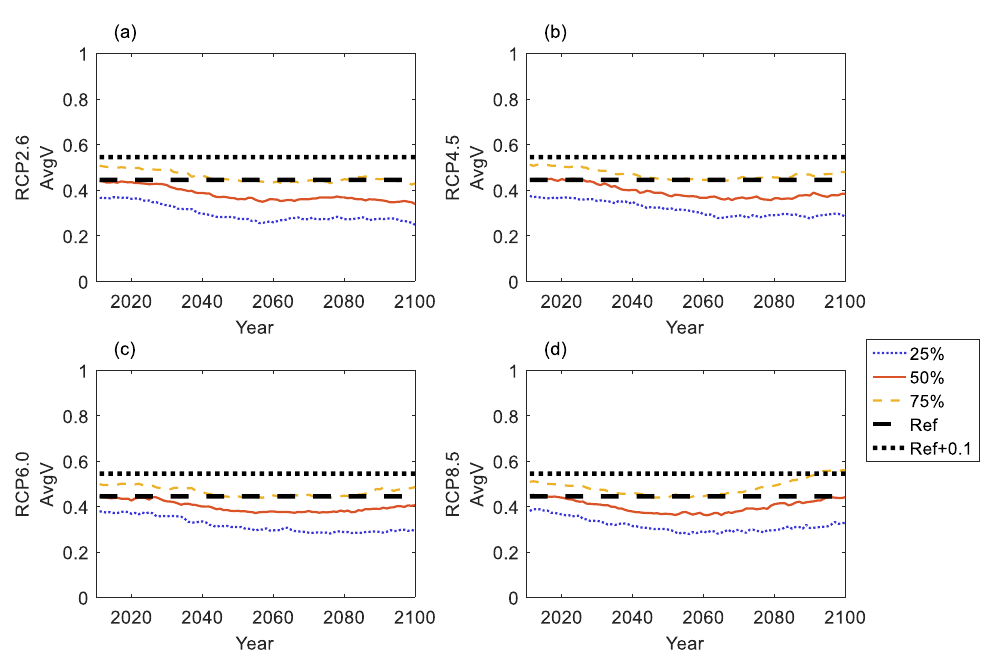
Figure 9. Maximum vulnerability under RCP 2.6 ( a ), 4.5 ( b ), 6.0 ( c ), and 8.5 ( d ) for a 40-year moving window, with the horizontal axis being the last year of the window. The thick dashed and dotted lines represent the reference historical performance and 10% worse-than-the-reference value, respectively.